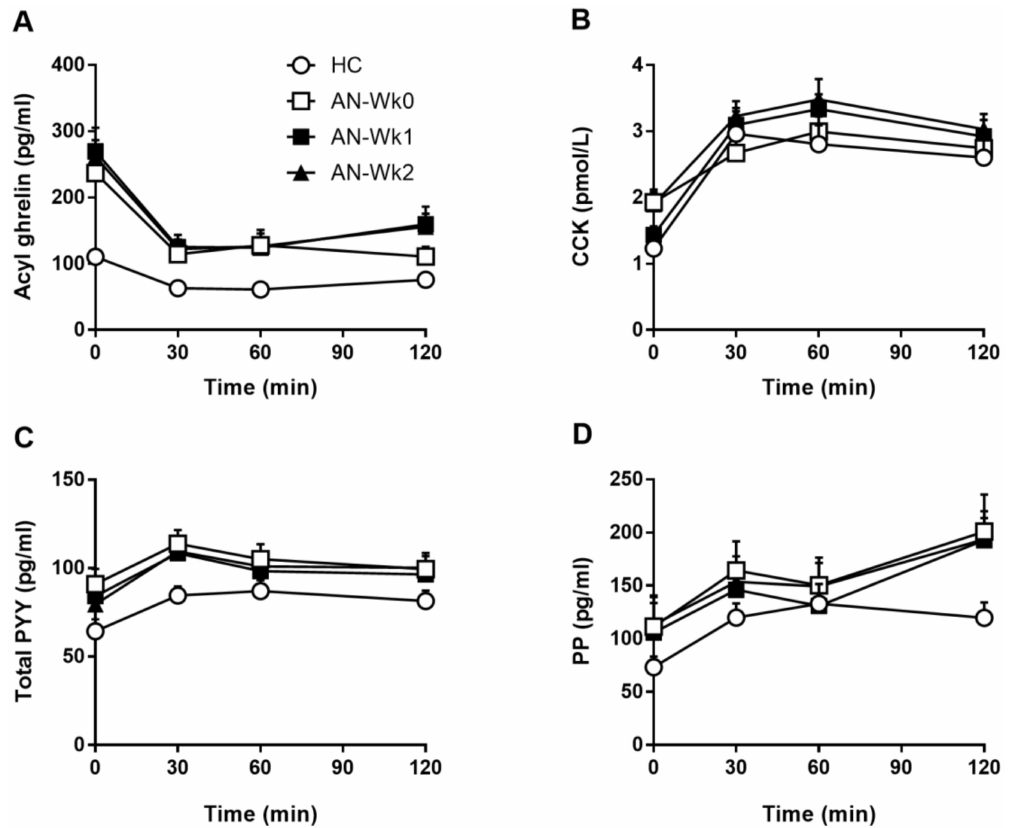
Figure 2. Acyl ghrelin ( A ), CCK ( B ) total PYY ( C ), and PP ( D ) concentrations before and after a mixed-nutrient, solid-liquid meal in 22 adolescent females with anorexia nervosa on admission (AN-Wk0), and after one (AN-Wk1) and two weeks (AN-Wk2) of refeeding, as well as in 17 age-matched healthy controls (HCs). Data are means ± SEM. For CCK: n = 16 HCs and n = 19 patients with AN due to missing